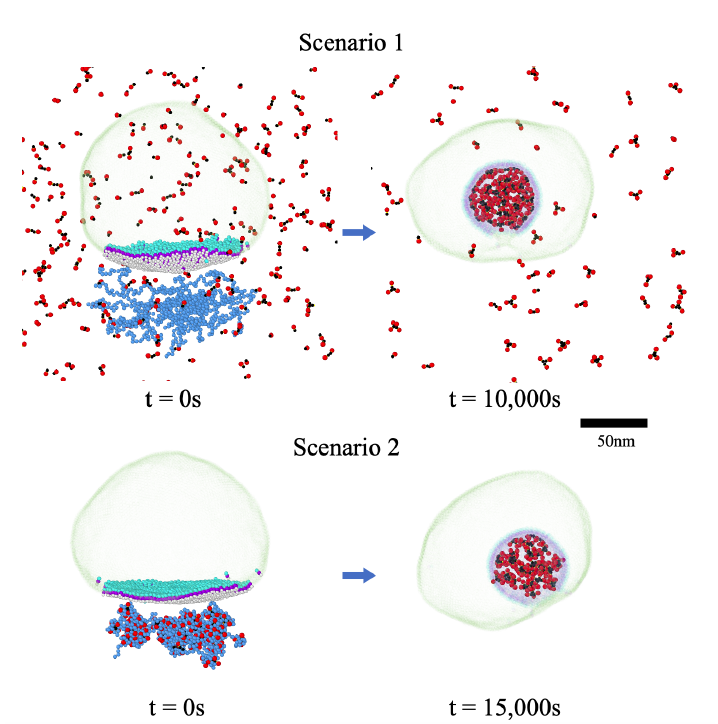
Figure 7. Snapshots of simulations of the budding process for two different cases: Scenario 1. Condensation of the genome occurs at the same time as the budding process. In this case, at the beginning of the simulations, the naked branched genome is located near the M proteins embedded in the ERGIC membrane surrounded by N proteins (25 µM), where the N-terminals of N proteins attract the genome and their C-terminals interact with M proteins, triggering both RNP condensation and budding simultaneously. Scenario 2: N proteins (25 µM) have already condensed RNA before the transport of RNP to the ERGIC interface. In this scenario, the N proteins within RNP are arranged such that their C-terminals interact with the endodomain of M proteins and trigger the budding process. For clarity, only the N proteins (not RNA) are shown after the completion of the budding process in both cases. For both scenarios, the genome length is L = 800 and genome charge is = 1, (cid:101) = 0, (cid:101) = 20, Z g = − 2, the interactions between proteins are (cid:101) McMc = 1, (cid:101) M M 3 M 3 N 3 N 3 2 M 2 = and (cid:101) N 3 M 3